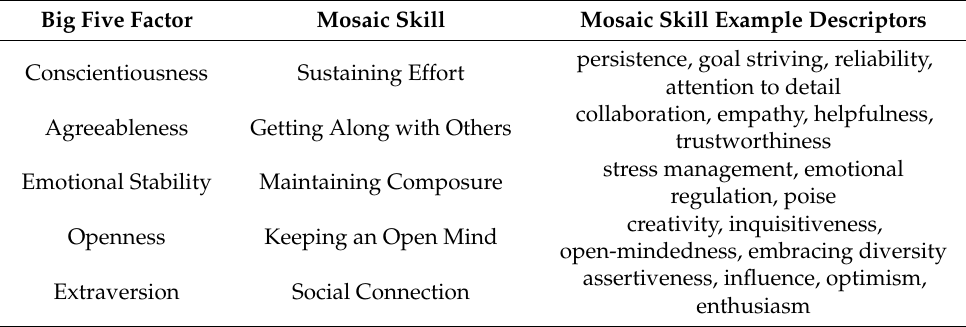
Table 1. Alignment of Mosaic Skills to the Big Five